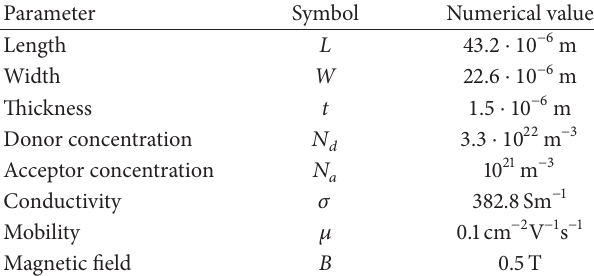
Table 3: Process 2